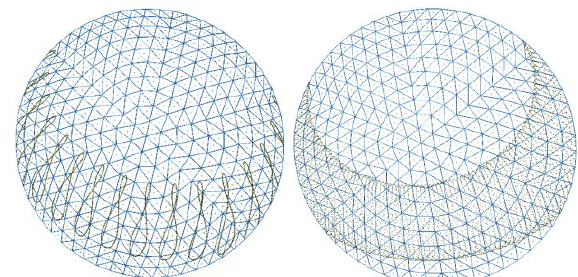
Figure 8 Comparison of distribution of sun in the Sky Patches Left: for every hour a curve is showing the sky position thought the year (not all 24 curves visible due to night time). Right: same for every 10 minutes (again not all 24*6=144 curves